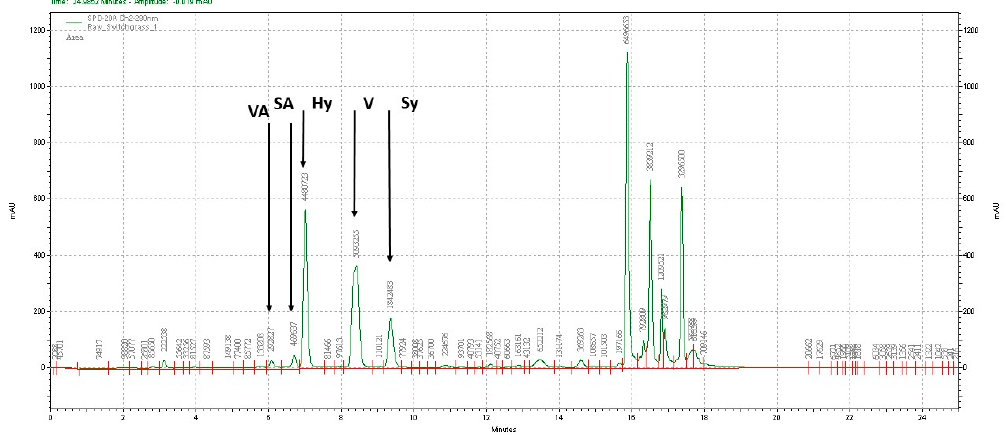
Figure 1. A representative HPLC chromatograph showing lignin degradation compounds generated during nitrobenzene oxidation (NBO). Hy: 4-hydroxybenzaldehyde; SA: syringic acid; Sy: syringaldehyde; V: vanillin; VA: vanillic acid.